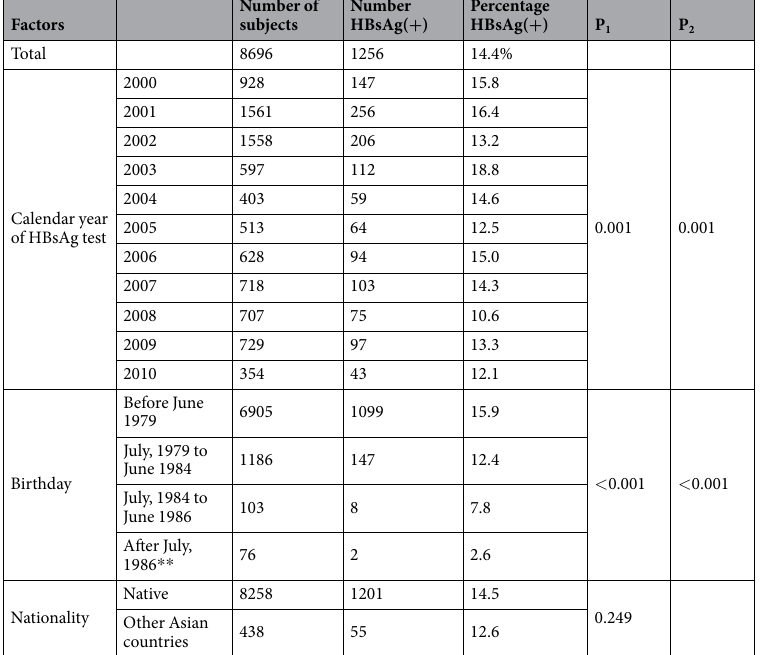
Table 1. Number of parturients and prevalence rate of positive HBsAg from 2000 to 2010. * P 1 . Pearson’s chi- square test;